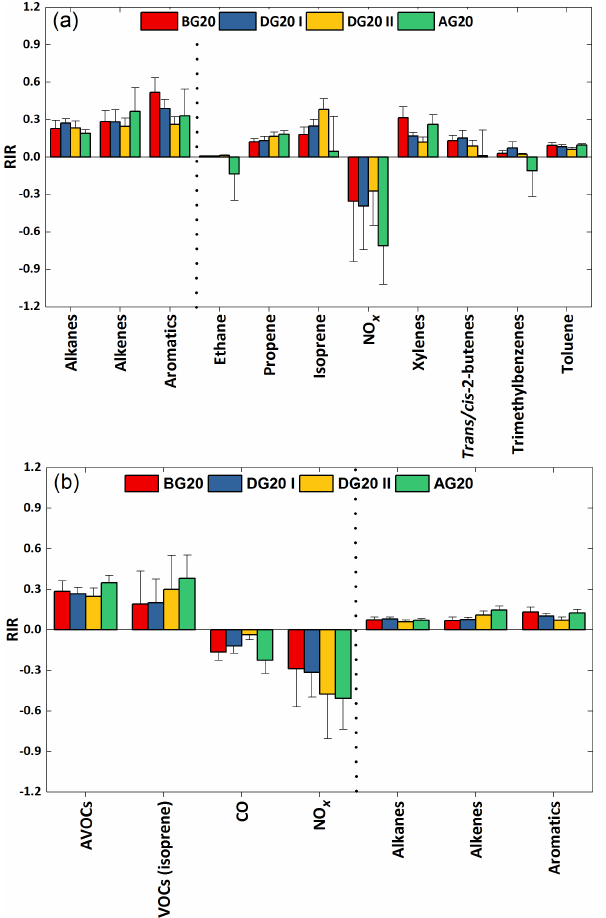
Figure 4. Sensitivity of PAN (a) and O 3 (b) production rate to major precursor groups and individual species (09:00–17:00CST). Error bars are standard deviations.